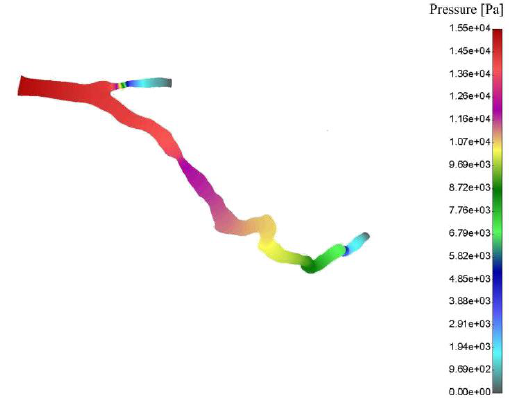
Figure 4. Pressure distribution of first patient [Pa]